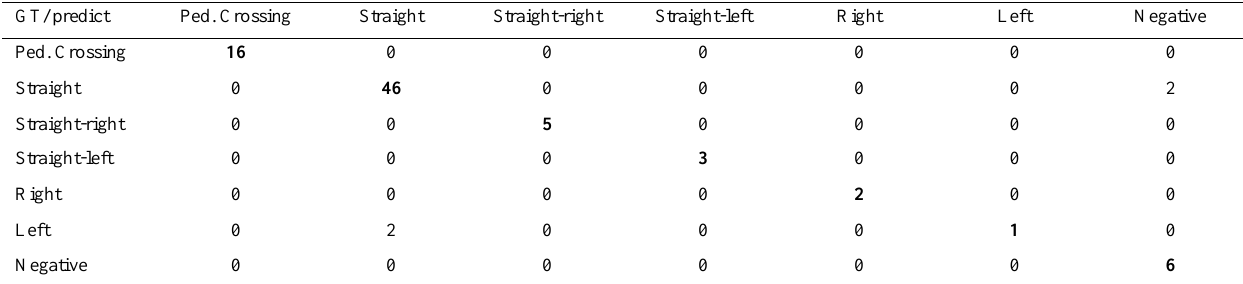
Table 3. Confussion Matrix in the second level of